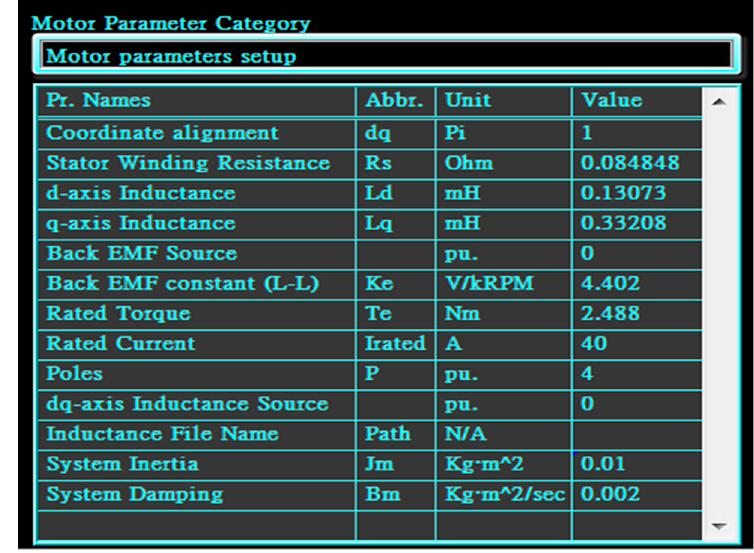
Figure 8. Curves of load vs current at 300 rpm by fixed torque angle method and fuzzy MTPA control.